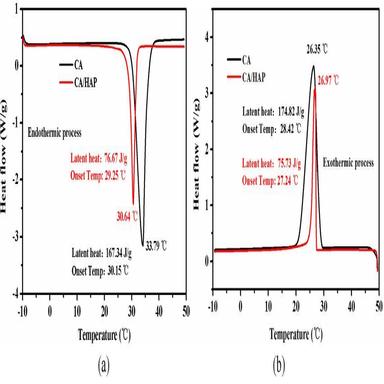
DSC curves of CA and CA/HAP composite (a) melting process; (b) freezing process.